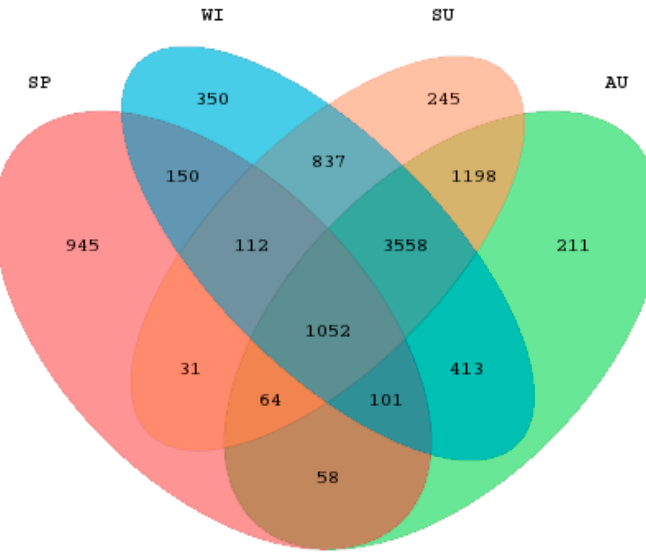
Figure 2. The Venn diagram of operational taxonomic units (OTUs) of sediment samples in spring, summer, autumn, and winter.